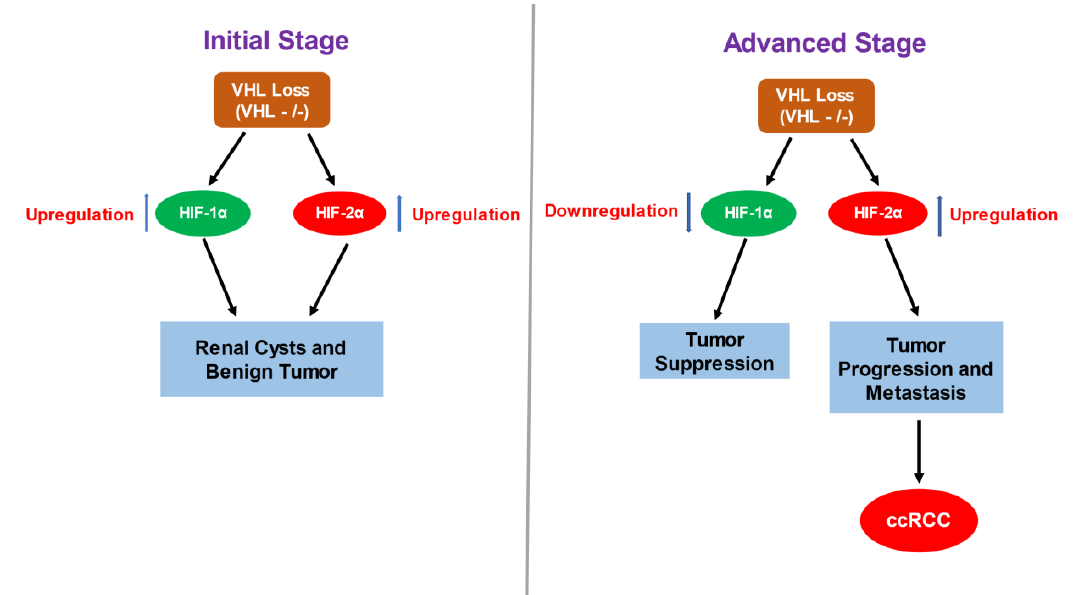
Figure 2. Contrasting Role of HIF-1α and HIF-2α in ccRCC progression. Loss of VHL leads to the upregulation of HIF-α isoforms: HIF-1α and HIF-2α, irrespective of oxygen availability in cell, which in turn contributes to the formation of initial renal cysts and tumors. Interestingly, only the HIF-1α isoform is expressed in normal tubular cells and the initiation of HIF-2α expression upon VHL loss, acts as an initial trigger for transformation of healthy tubular cells. Overtime, the expres- sion of HIF-2α prevails over HIF-1α expression, which is associated with tumor growth, progression and metastasis. Furthermore, HIF-1α attenuates expression of several pro-tumorigenic genes which otherwise are stimulated by HIF-2α suppressing the malignant phenotype.